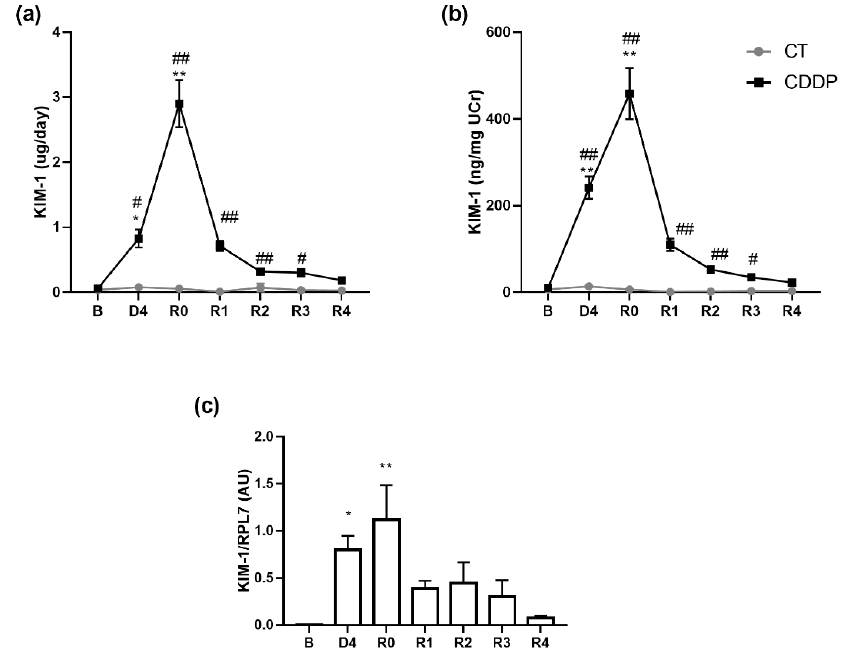
Figure 6. Urinary excretion of KIM-1 normalized by both urine flow ( µ g/day) ( a ) and urine creatinine (ng/mg UCr) ( b ) and KIM-1 mRNA expression in renal tissue ( c ). B: basal; CDDP: cisplatin treatment (5 mg · kg − 1 body weight) group; CT: control group; D4: day of maximum kidney damage after cisplatin treatment; R0: day of recovery; R1: 1 week after recovery; R2: 2 weeks after recovery; R3: 3 weeks after recovery; R4: 4 weeks after recovery. * p < 0.05 vs. B; # p < 0.05 vs. CT; ** p < 0.01 vs. B;